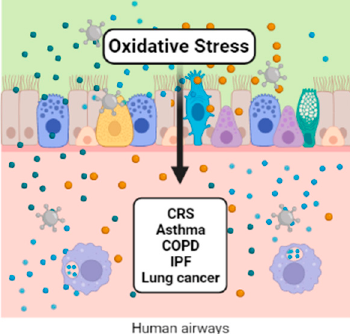
Figure 1. Oxidative stress activates the lungs’ epithelial cells, generating inflammatory mediators that participate in the macrophage activation and the modulation of gene expression and transcription factors. All of them are implicated in numerous respiratory diseases.